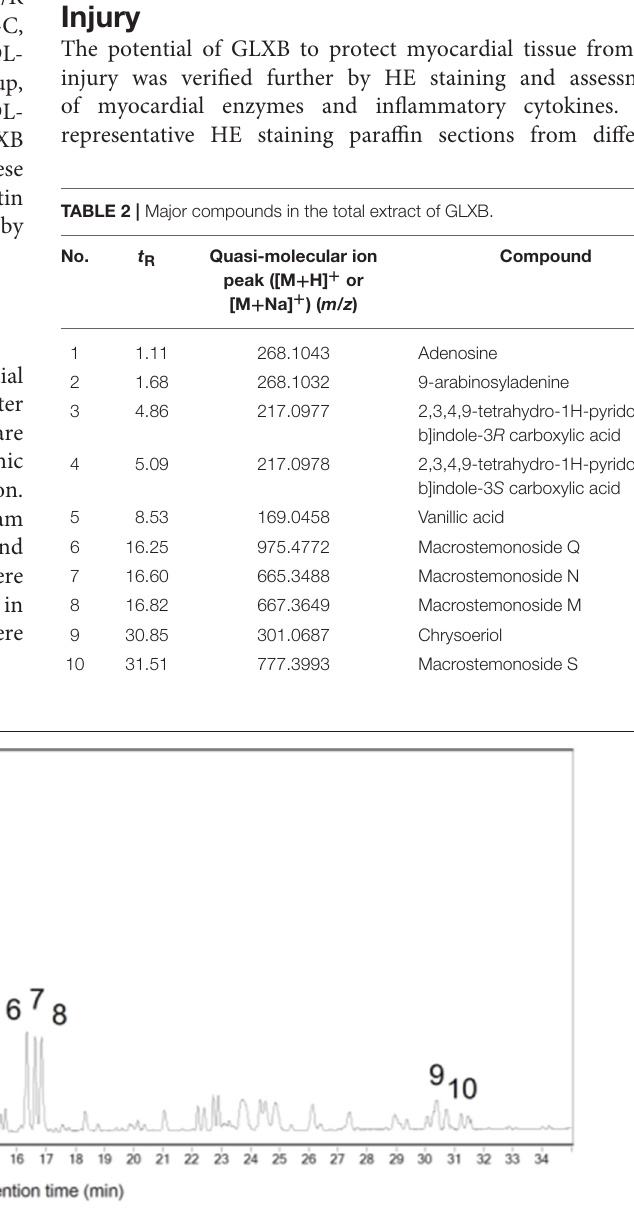
FIGURE 1 | Base peaks in chromatography (BPC) of the total extract of GLXB in positive mode (time/B%): 0–5min, 3–10%; 5–15min, 10–15%; 15–16min, 15–18%; 16–20min, 18–20%; 20–30min, 20–30%; 30–35min, 30–40%.